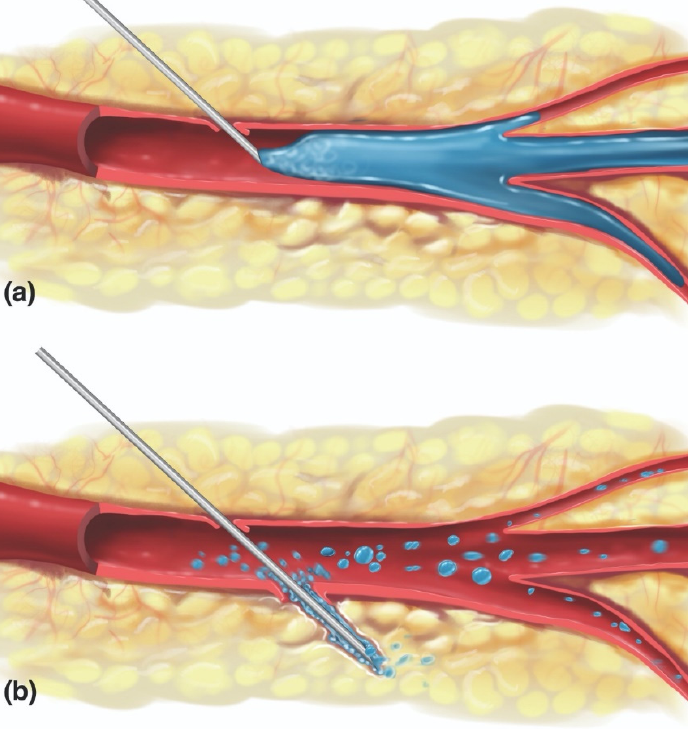
Figure 9. Mechanisms of vaso-inoculation. ( a ) Direct intraluminal injection. ( b ) Indirect extraluminal inoculation following trans-arterial